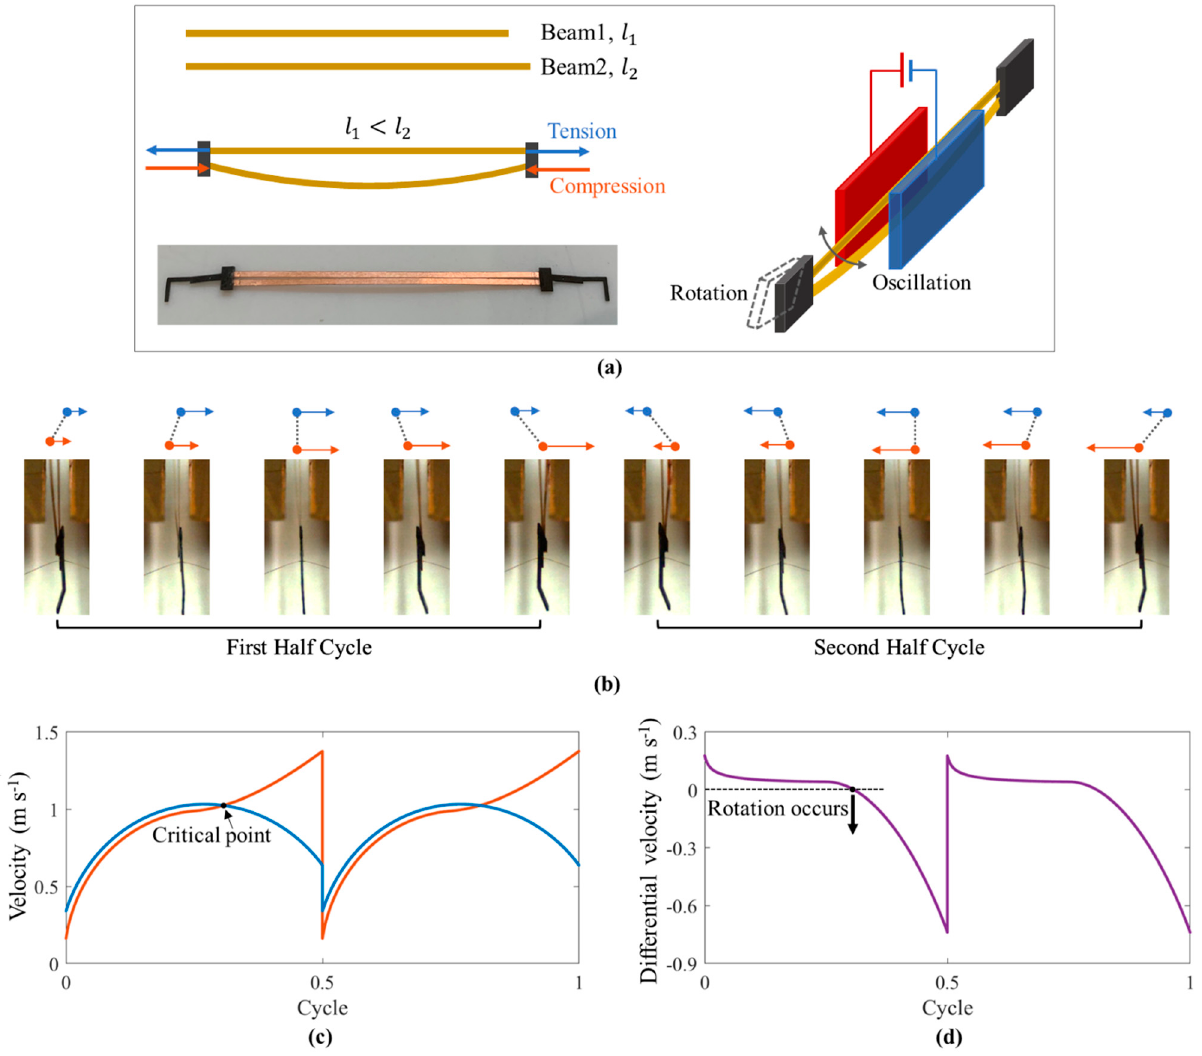
Figure 8. The differential motion of the two beams in the double-beam resonator: ( a ) the structure of the novel double-beam resonator; ( b ) the differential motion of the double-beam resonator is captured by the high-speed camera (the camera is posed in position 2 shown in Figure 2a); ( c ) the velocity output of each beam during one motion cycle; ( d ) the differential velocity output between two beams in one motion cycle, where the differential length of two beams is 1 mm, and the powering voltage is 4.5